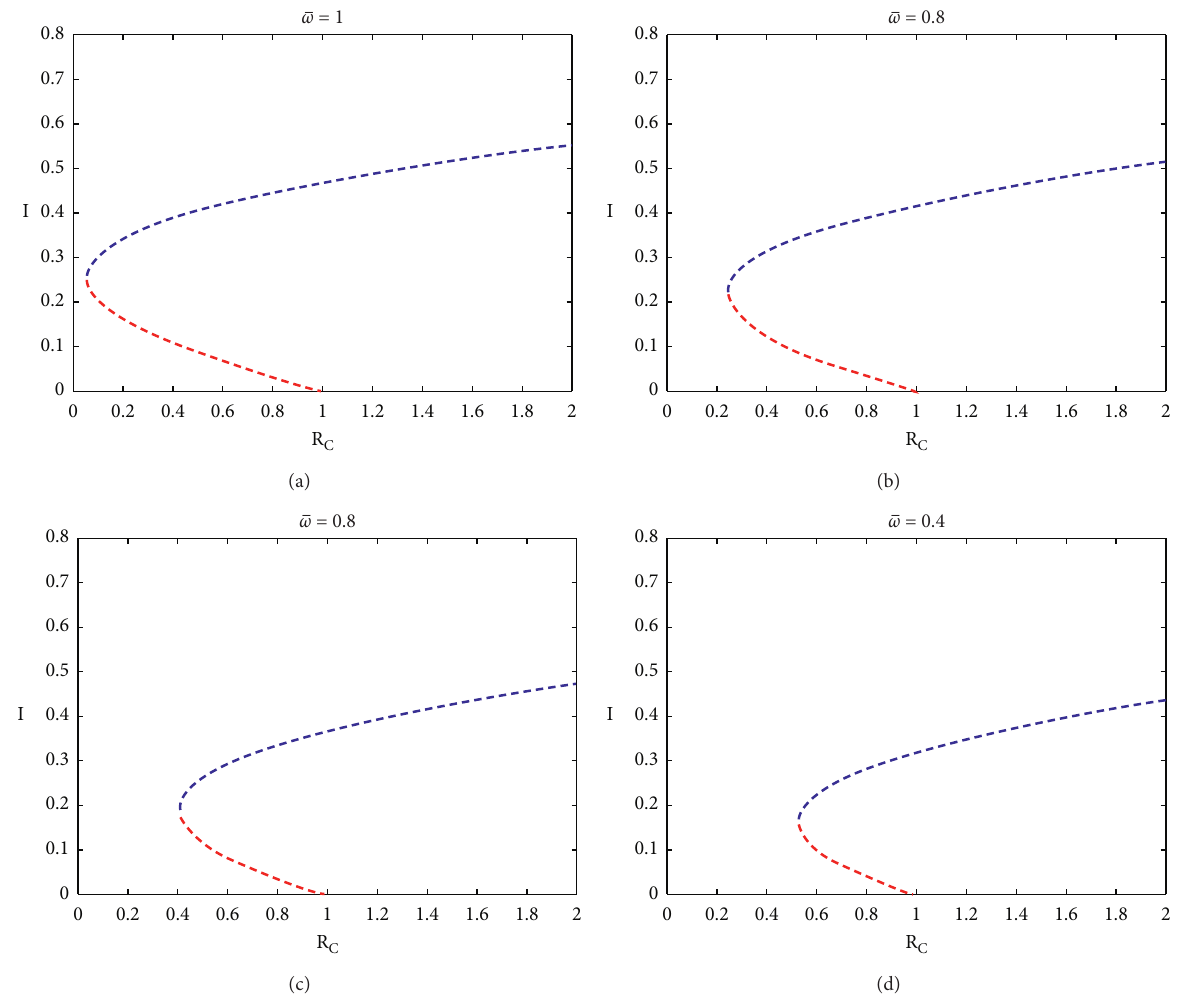
Figure 9: Demonstrations of the impact of varying the parameter that accounts for delaying the treatment of infected individuals. Here the parameters are the same as in Figure 8 except c � 1.2 while ϖ is shown on top of the figure. (a) Forward bifurcation. (b) Backward bifurcation. (c) Forward bifurcation. (d) Backward